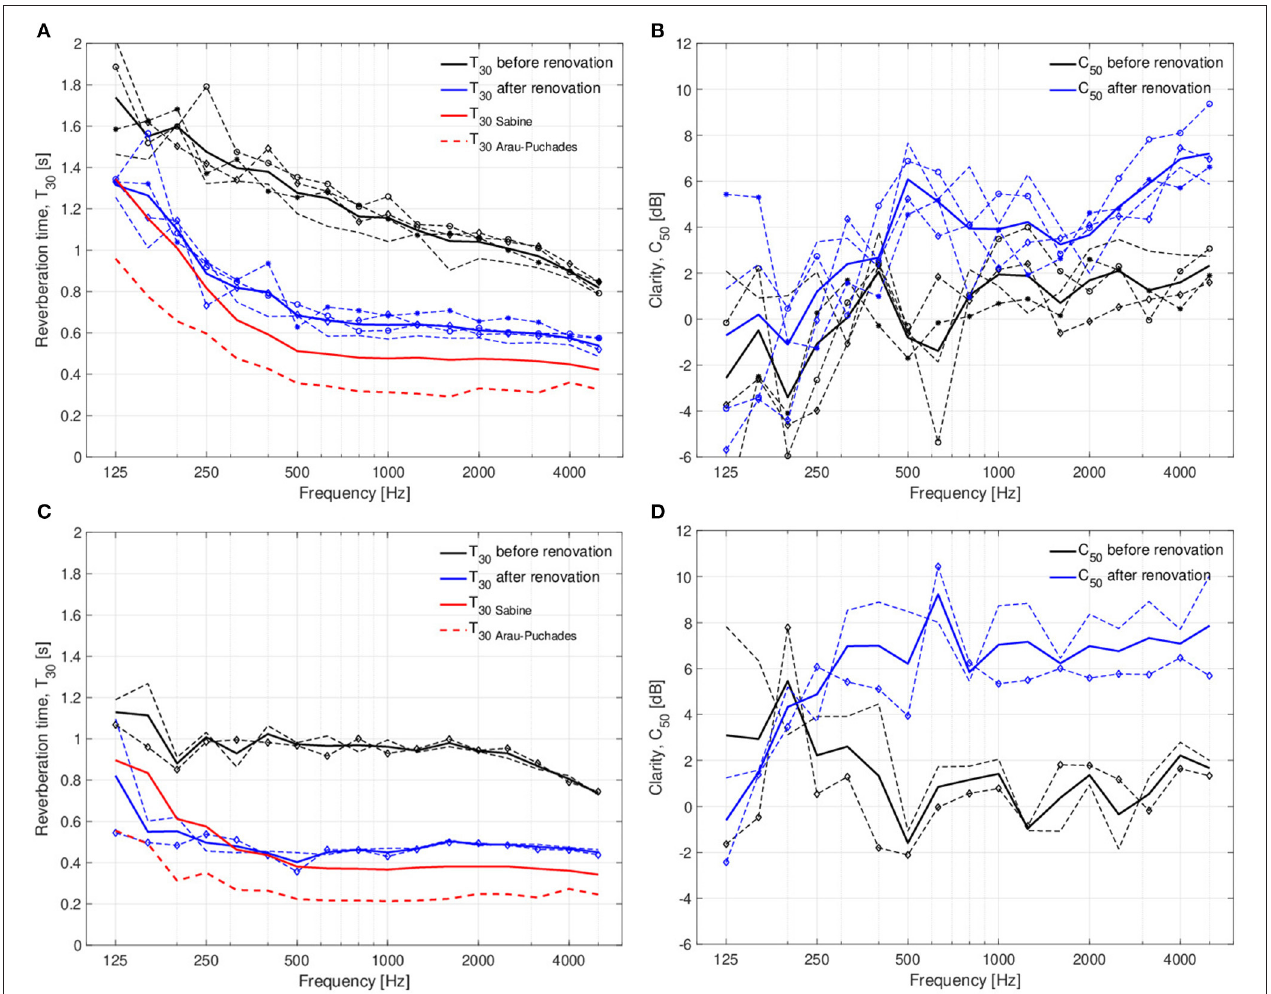
FIGURE 4 | Measurement results of T 30 and C 50 before and after the installation of acoustic treatments in the Co-founder spaces. Common office space (A,B) , and meeting room (C,D) . Reverberation time predictions according to Sabine’s and Arau-Puchades theories are included in (A)